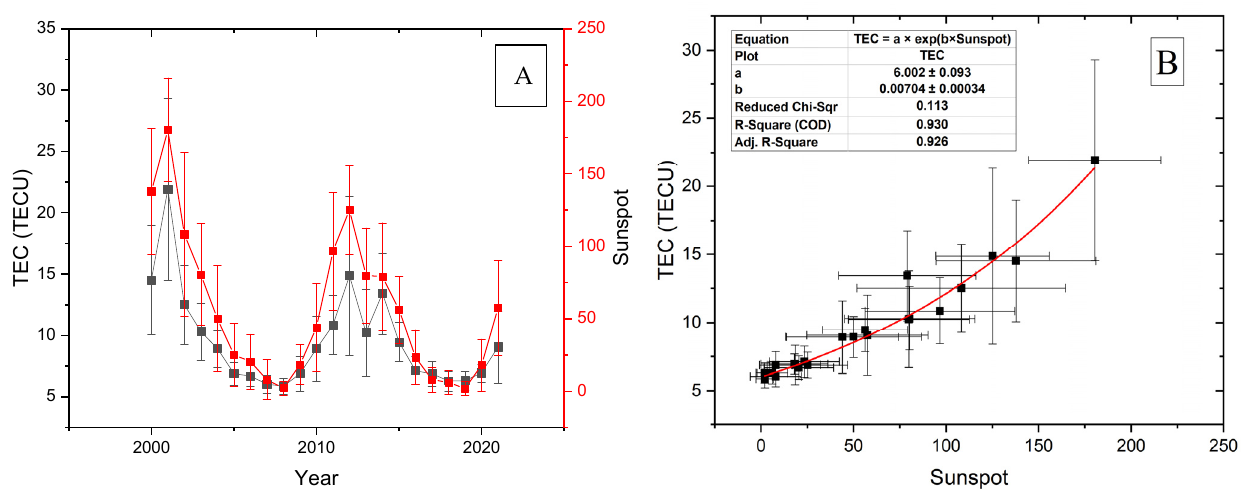
Figure 5. ( A ) TEC and Sunspot number time trend in the investigated period from 2000 to 2021. Each year is the average value from 22 October until 20 April of the following year (e.g., 2000 = 22 October 2000/20 April 2001, …, 2021 = 22 October 2021/20 April 2022). ( B ) TEC versus Sunspot number. Each error bar represents one standard deviation of the original data distribution in the six months used for the average calculus. An exponential fit is superposed as a red curve, and their coefficients and statistical goodness parameters are reported in the embedded table.